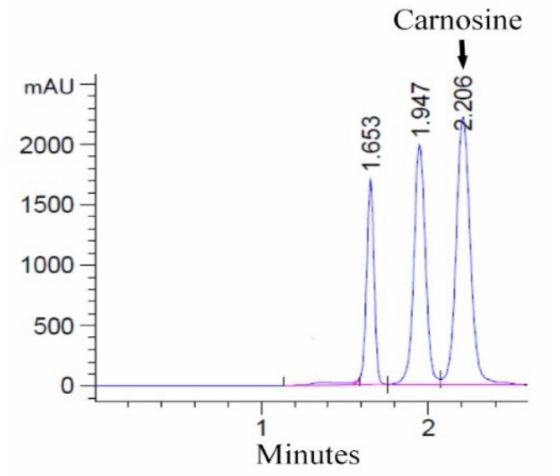
Figure 1. HPLC chromatogram of carnosine extracted from breast muscle